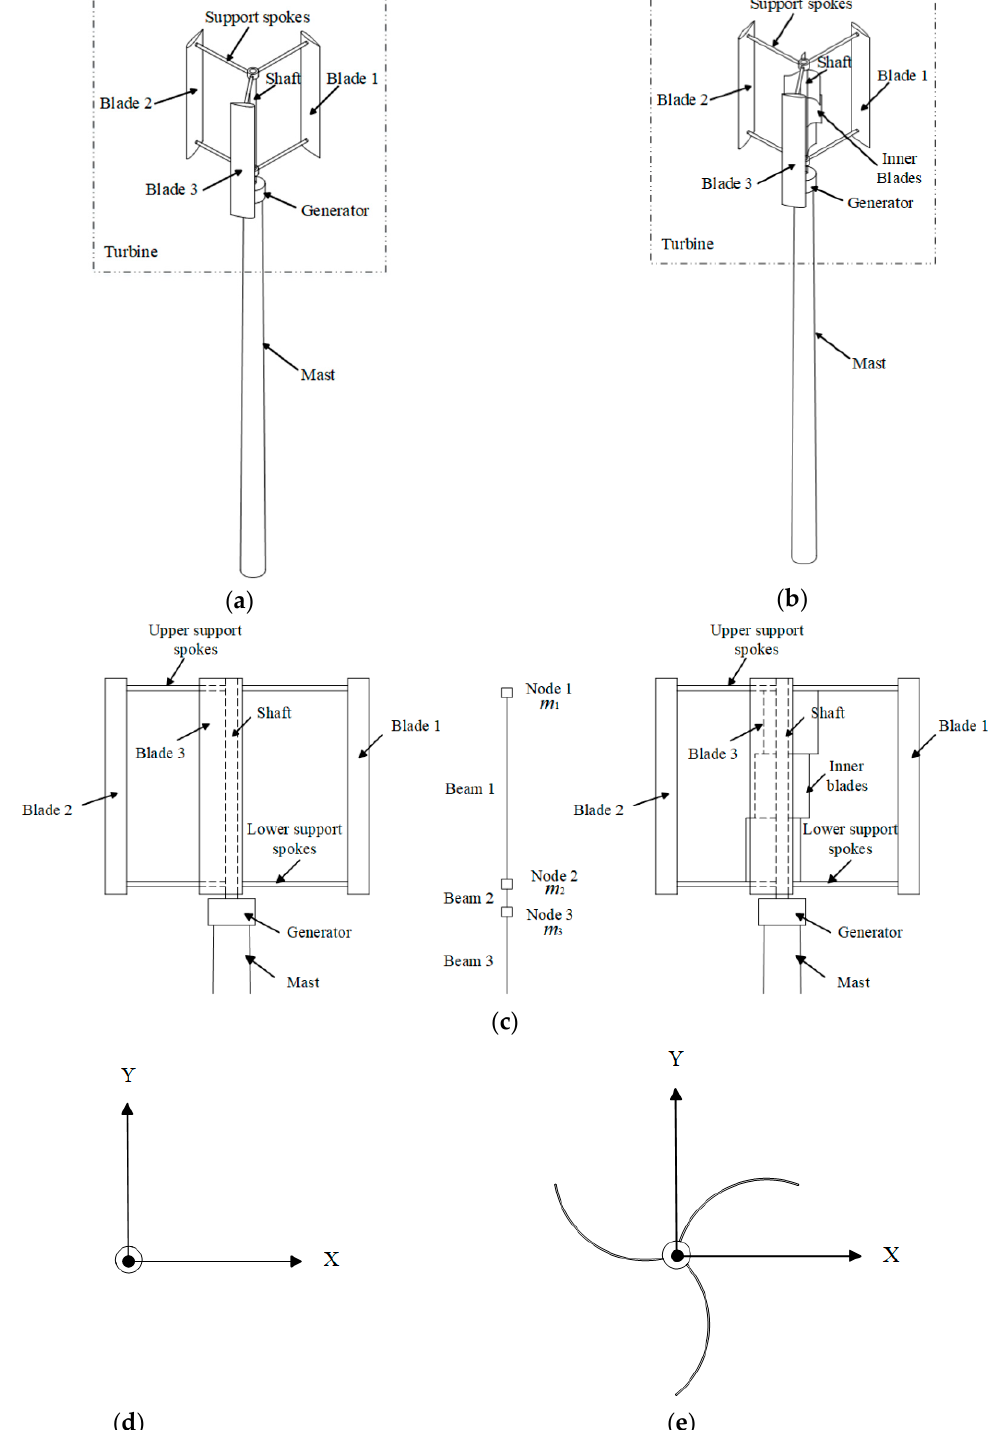
Figure 4. Main parts of the ( a ) H ‐ type and ( b ) hybrid VAWTs and ( c ) their MDOF model; ( d ) an H ‐ type VAWT shaft cross ‐ section and ( e ) hybrid VAWT shaft and inner blade cross ‐ sections.